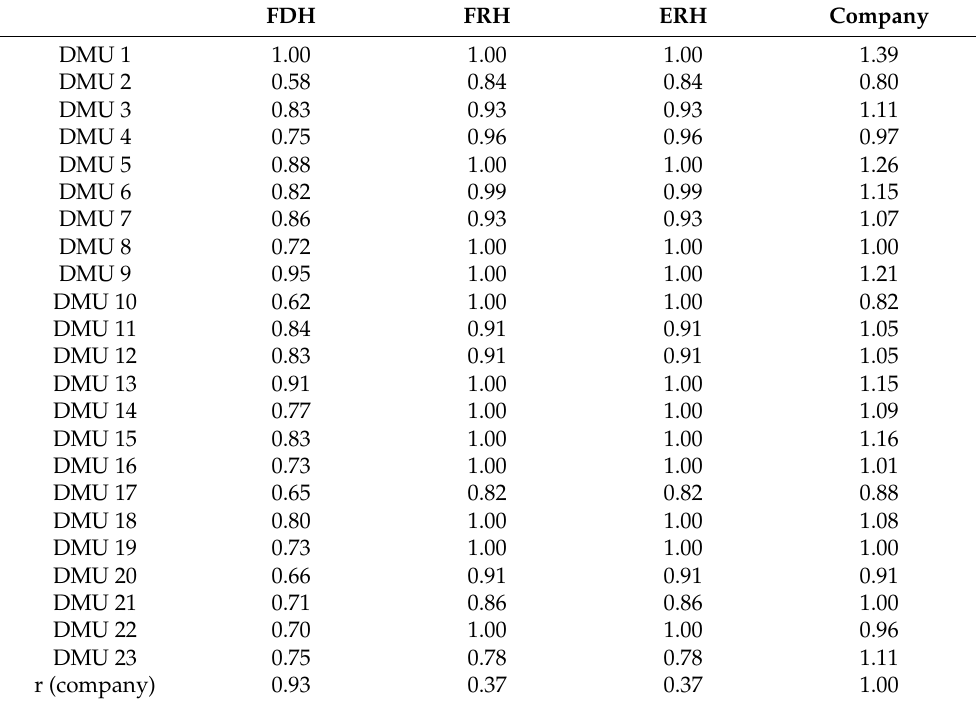
Table 2. Results of non-convex models and company